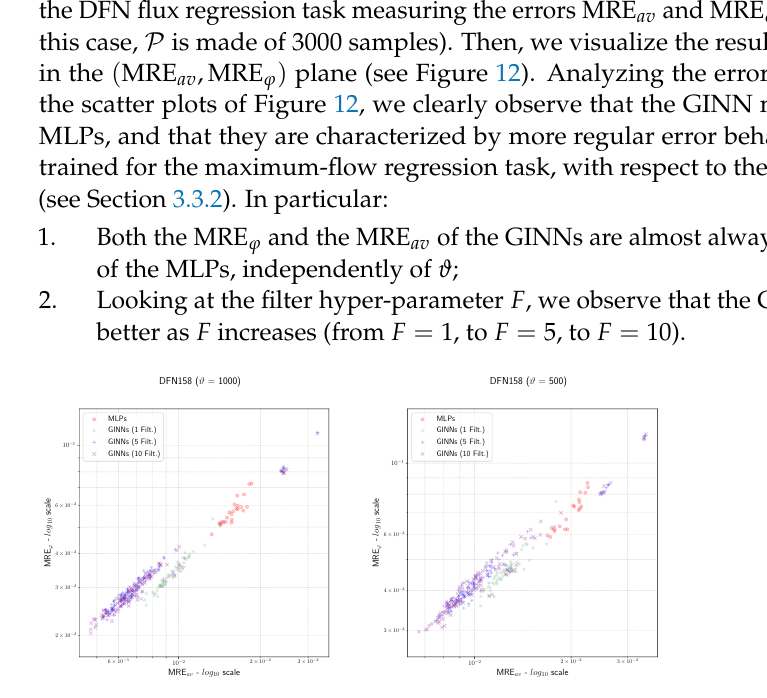
Figure 12. Scatter plots in the ( MRE av ,MRE ϕ ) plane for NNs trained with respect to DFN158. NNs are trained using ϑ = 1000 ( left ) and ϑ = 500 ( right ) samples. Red circles: MLPs; green stars, blue crosses and purple “x”: GINNs with F = 1,5,10,